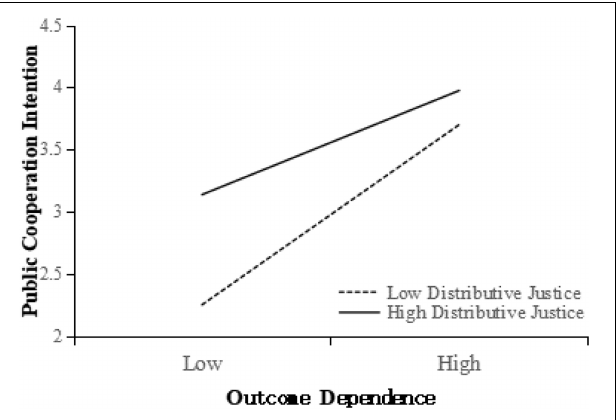
FIGURE 3 | Interaction effect of distributive justice and outcome dependence on public cooperation intention.